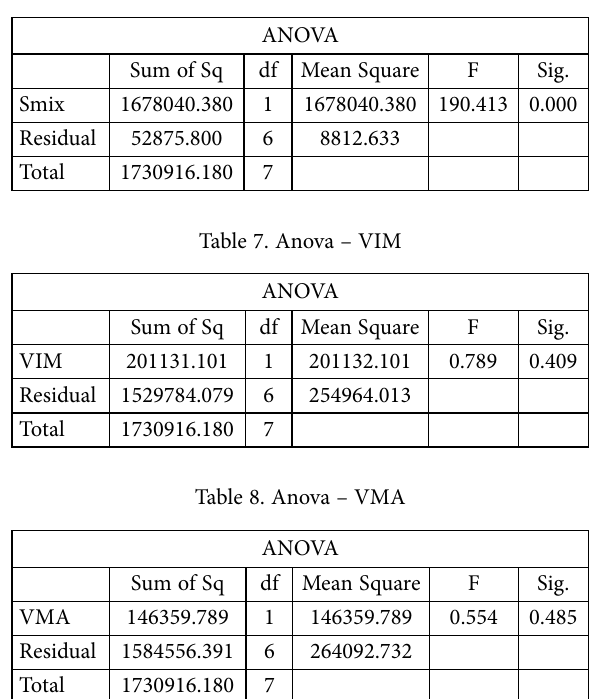
Figure 10. Hamburg Wheel Tracking Test for HMA, WMA, HAR, and WAR Table 6. Anova – Resilient modulus mix